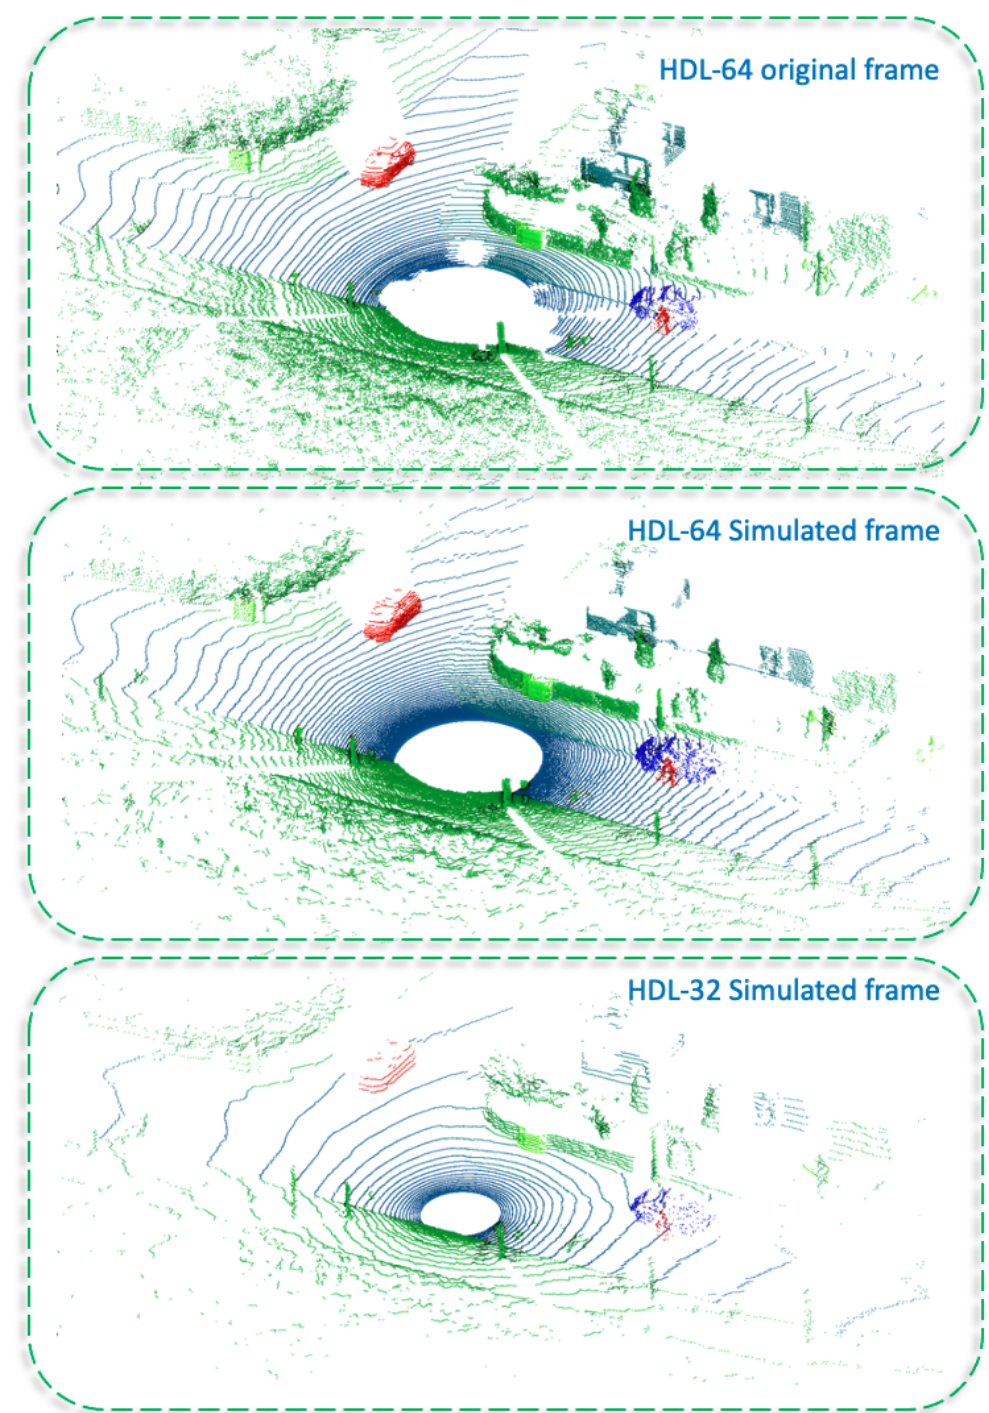
Figure 14. Showing an original frame from the SemanticKITTI [18] sequence 08 dataset with dynamic objects ( top ). The simulated HDL-64 LiDAR at the same position with dynamic objects ( middle ). The simulated HDL-32 LiDAR translated by − 0.5 m on the z -axis ( bottom